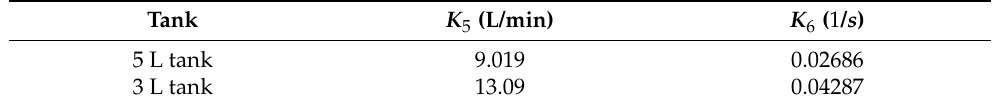
Figure 9. Comparison of experimental flow and calculated flow. The parameters of ∆ q m were identified according to Equation (16), and the parameters are shown in the Table 3. Table 3. Identification parameters of flow